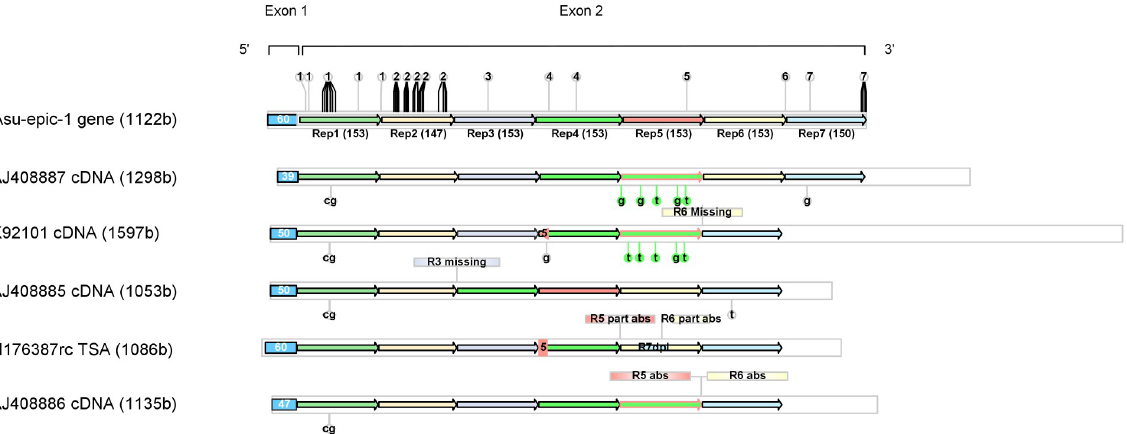
Fig 3. Schematic representation of the nucleotide sequence of the Asu-epic-1 gene and five cDNA/TSA sequences. The nucleotide sequences (total length in parenthesis) are represented by light gray bars. The exon1 coding for the signal peptide is indicated as a light blue box. Arrows in different colors represent the seven tandem repeats of exon two (see Fig 2). The specific nucleotides of a given repeat of the Asu-epic-1 sequence are shown as numbers above their position in the repeat sequence. In the cDNA/TSA sequences, missing repeats are indicated above their correct corresponding position. Duplicated repeats or parts of them are represented with the color of the corresponding repeat. Their colored borders indicate the type of missing repeat. Single nucleotide differences in comparison to the Asu-epic-1 gene are indicated below the